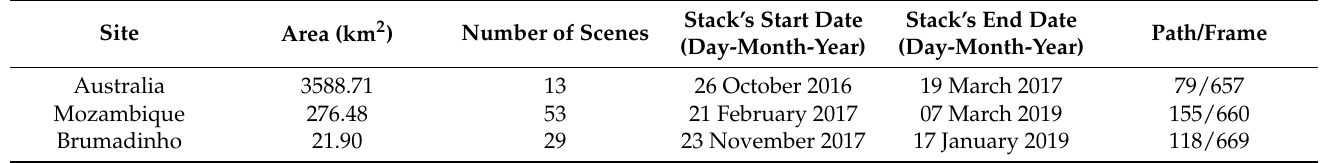
Table 1. Data collected for the three study